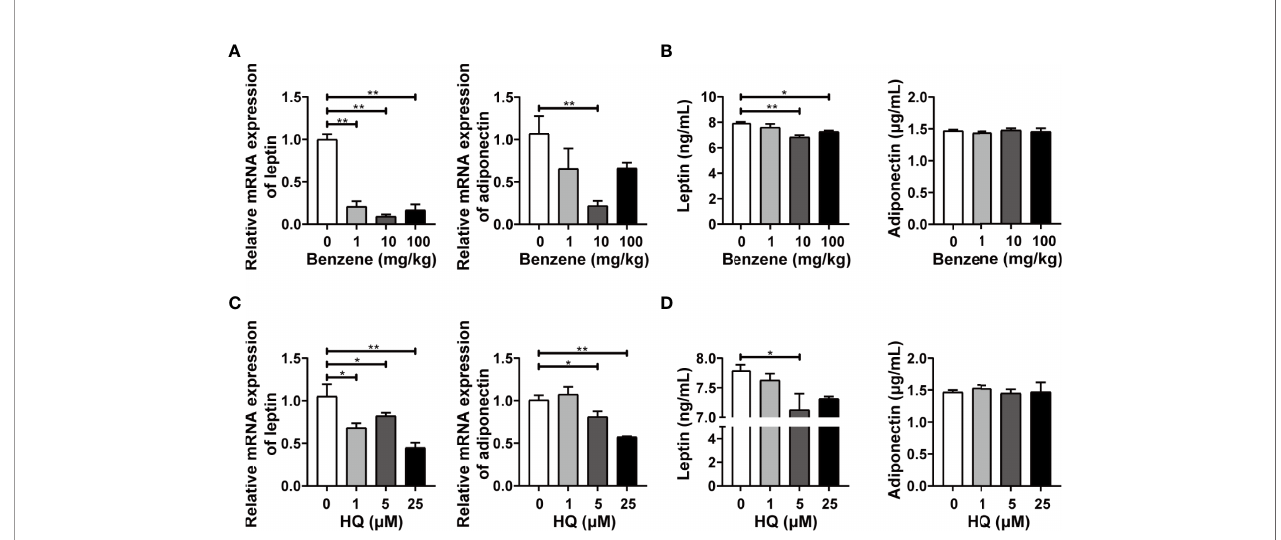
FIGURE 8 | The endocrine activity of white adipose tissue (WAT) and in vitro adipocytes. Adult male C57BL/6J mice were exposed to benzene at doses of 0, 1, 10 and 100 mg/kg for 4 weeks. Then the mRNA levels of leptin and adiponectin were detected in eWAT (A) , and those of plasma levels were detected using ELISA (B) (n = 5-6). Mature adipocytes were exposed to HQ at 0, 1, 5 and 25 m M for 24 hours. Then the mRNA levels of leptin and adiponectin were detected (C) , and the medium content of leptin and adiponectin was examined using ELISA (D) (n = 3-4). Data are presented as mean ± SD. One way ANOVA were performed; * p < 0.05, ** p < 0.001 (compared to the control group).